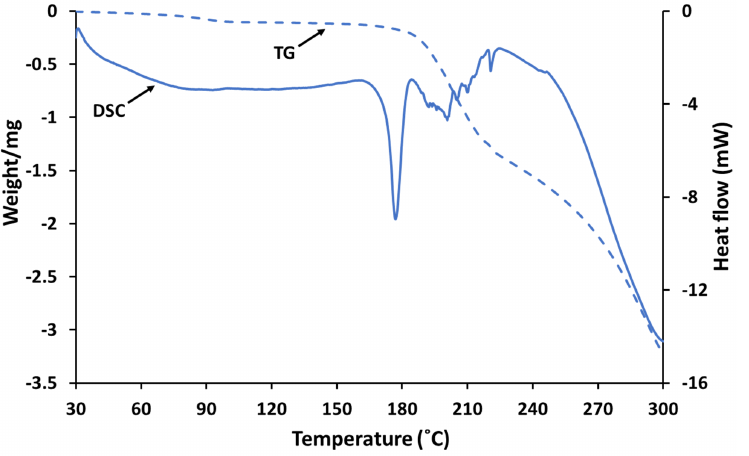
Figure 9. DSC and TG profiles of DPA:TA salt obtained from the slow evaporation Figure 9. DSC (solid line) and TG (dashed line) profiles of DPA:TA salt obtained slow evaporation method.